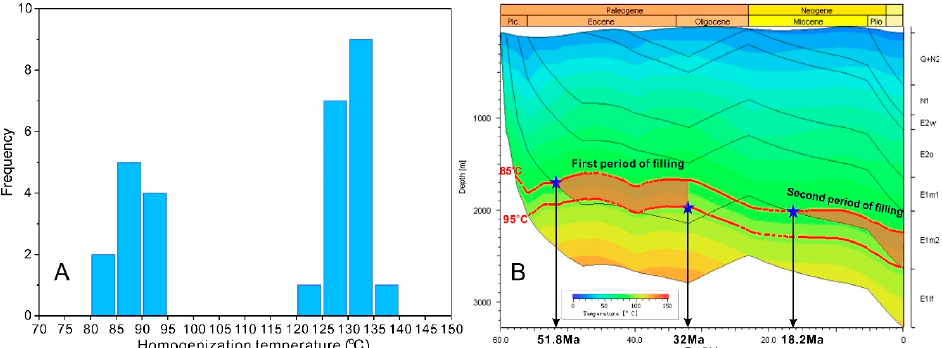
Figure 17. Determine the petroleum filling period using the fluid inclusion homogenization temperature analysis method. ( A ) Homogenization temperature distribution diagram from sandstone samples from Well LS36-A and Well LS36-B. ( B ) 1D structure and temperature history model of Well LS36-A indicating the two periods of hydrocarbon filling.